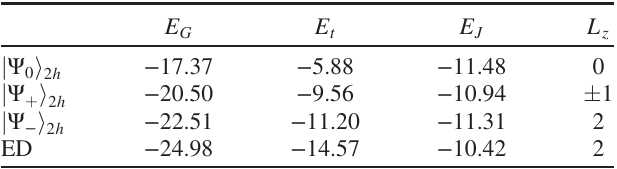
TABLE II. The energies of the two-hole ground states j Ψ 0 i 2 in Eq. (13), on a 4 × 4 lattice under OBC: E Eq. (14) and j Ψ i 2 (cid:2) h is the total energy; E and E are the kinetic and the super- t J 0 ; (cid:2) 1 , 2 denote the cor- exchange energies, respectively; L z ¼ responding orbital angular momenta.